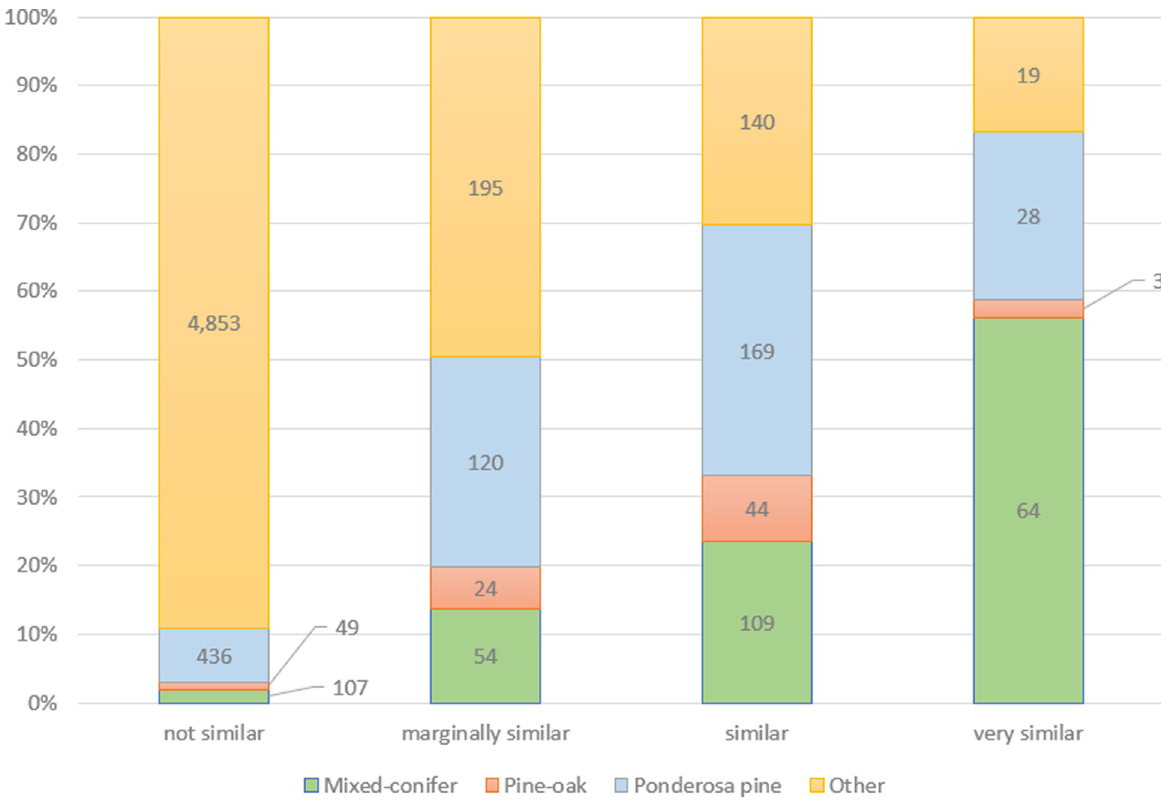
Fig 5. Distribution on FIA plots by forest type and similarity class. Numbers in columns indicate plot count of the specific forest type. Mixed- conifer and pine-oak were defined using descriptions in USFWS 2012. Ponderosa pine and Other were defined by FIA